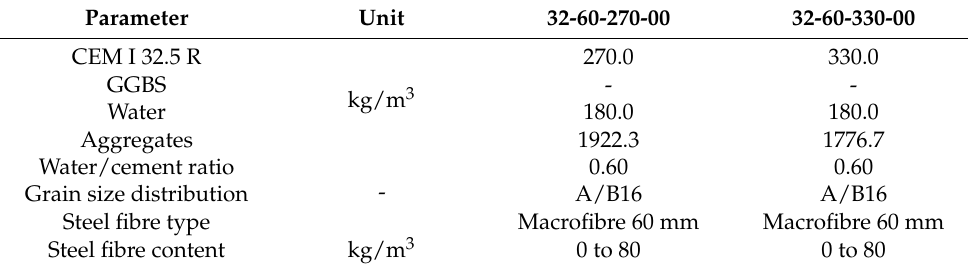
Table A2. Concrete mix designs for the variation of the binder content.